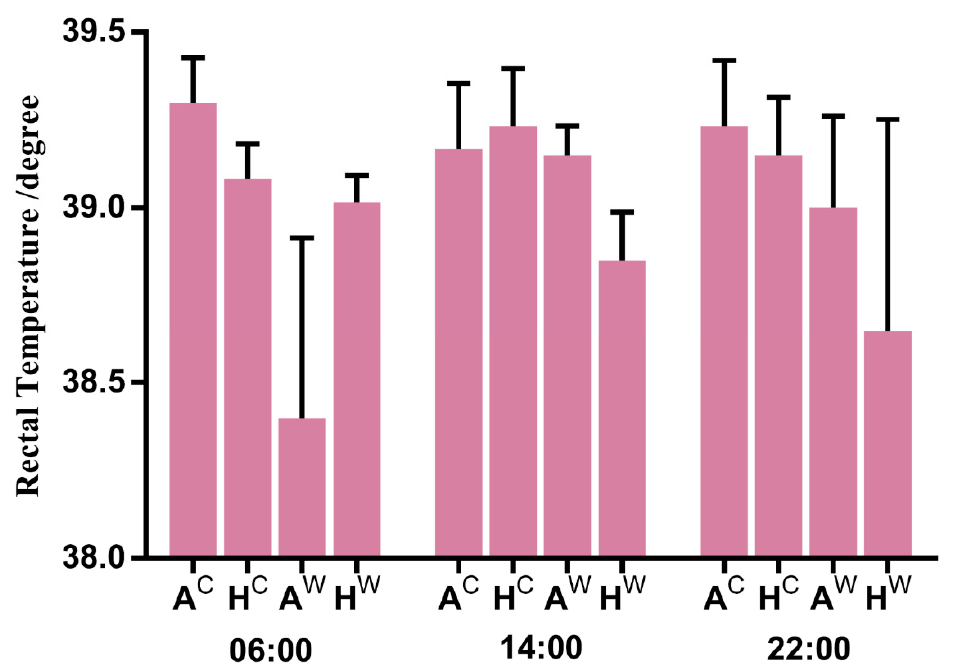
Figure 1. Rectal temperature of Altay and Hu lambs maintained at different air temperatures. The rectal temperatures of the lambs were measured on day 36 of the study at 06:00, 14:00 and 22:00. A c : Altay lambs at − 5 °C, H c : Hu lambs at − 5 °C, A w : Altay lambs at 20 °C, and H w : Hu lambs at 20 °C. Values are means ± SD from 6 lambs per group.